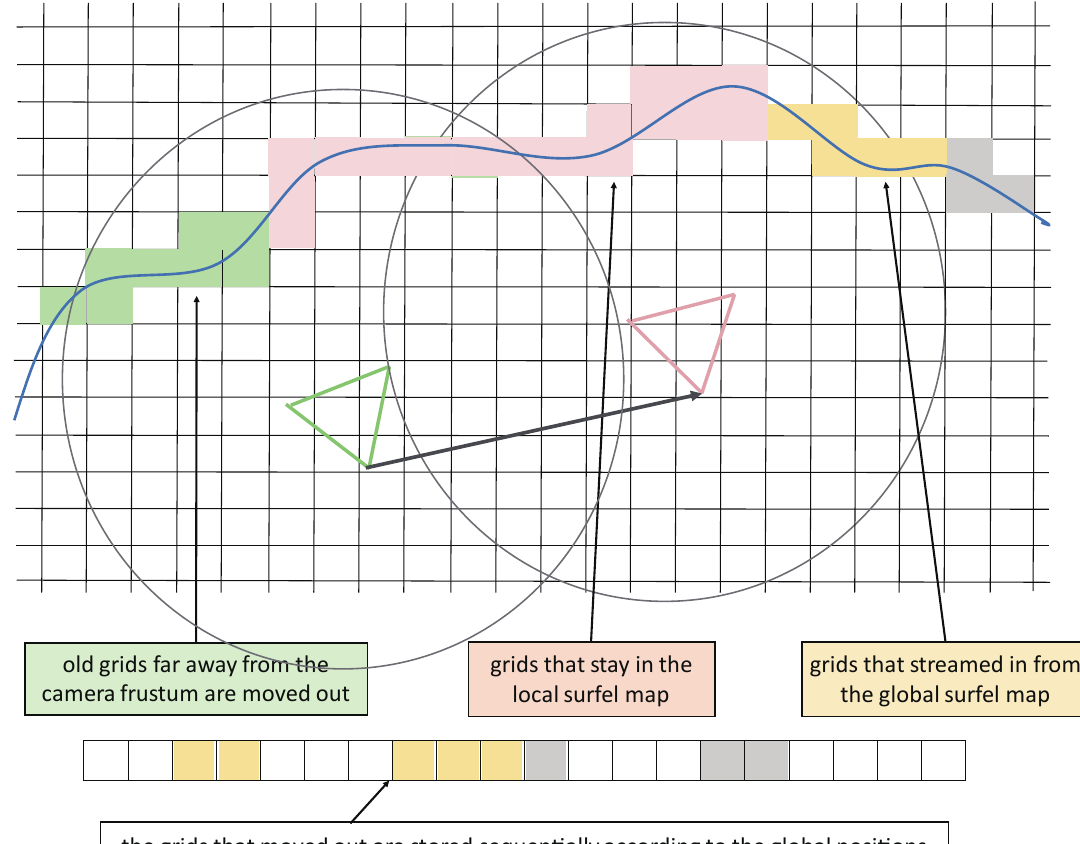
Figure 2. Surfel streaming in our system. An active region is defined as a sphere containing the current camera frustum. The sphere center is located at two meters from the camera. The radius of the sphere is set to eight meters. The grid timestamp is set to the latest timestamp of the surfel in the grid. The surfels in the local map are divided into equal-sized grids. The old grids far away from the current camera frustum are moved to the global map. In addition, the grids in the global map that are close to the current frame frustum are streamed back. The grids in the global map are sequentially stored according to their global